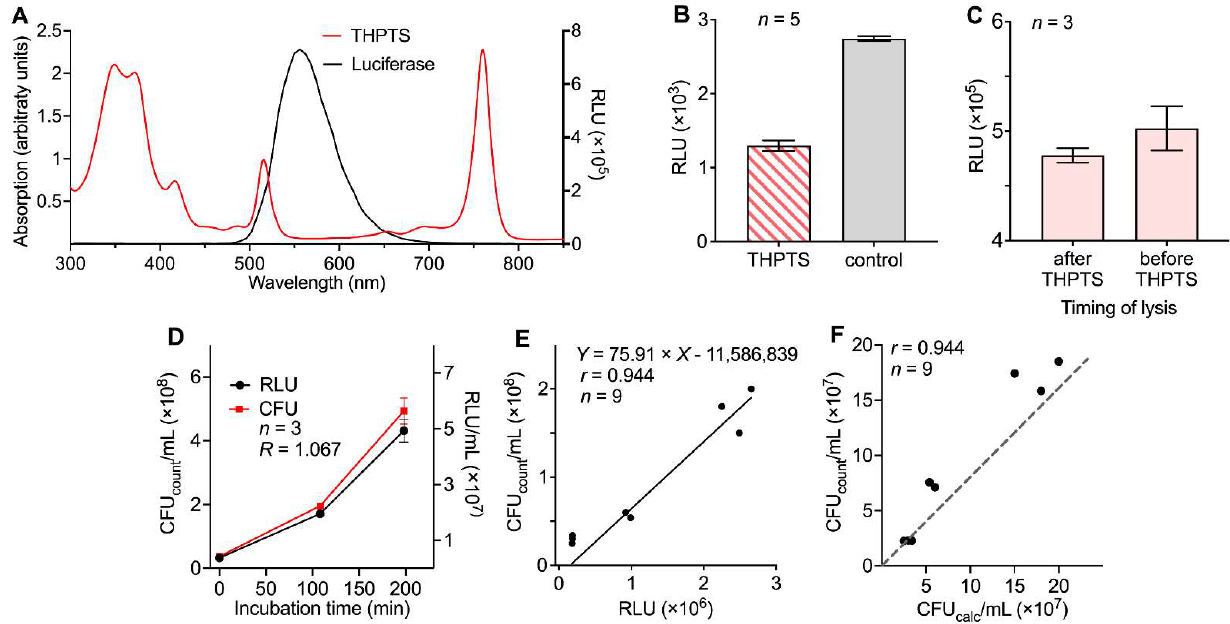
Figure 5. Correlation of bacterial densities as determined by luminescence and manually counting in the presence of the photosensitizer THPTS: ( A ) The absorption spectrum of THPTS dissolved in 0.9% NaCl was measured. Additionally, the luminescence spectrum of the luciferase used in the cell viability assay is presented. ( B ) Background luminescence of 50% BHI broad medium (dissolved in 0.9% NaCl) with 200 µ M THPTS compared to 50% BHI broad medium alone. ( C ) Bacteria-lysing property of the assay was measured with and without THPTS in M. morganii . ( D ) Bacterial growth curve of VRE E. faecium , incubated in BHI broad medium at 37 ◦ C, 5% CO 2 , detected at indicated time points. Density of bacteria was determined by luminometric assay and colony counting (CFU count ). ( E ) Correlation between results from luminometric readings and calculated colony density (CFU calc ) in VRE E. faecium , with results of luminometry in heat-inactivated bacteria used to define zero CFU/mL. ( F ) Correlation between CFU calc and CFU count of VRE E. faecium; r = correlation coefficient.